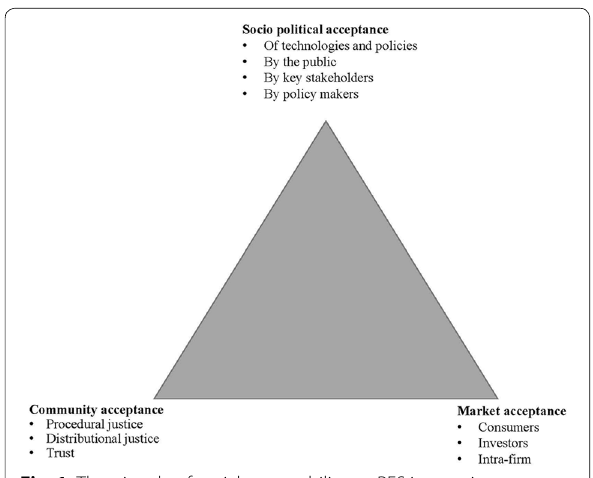
Fig. 1 The triangle of social acceptability on RES innovation (Wüstenhagen et al. 2007) (Source: https ://doi.org/10.1016/j.enpol